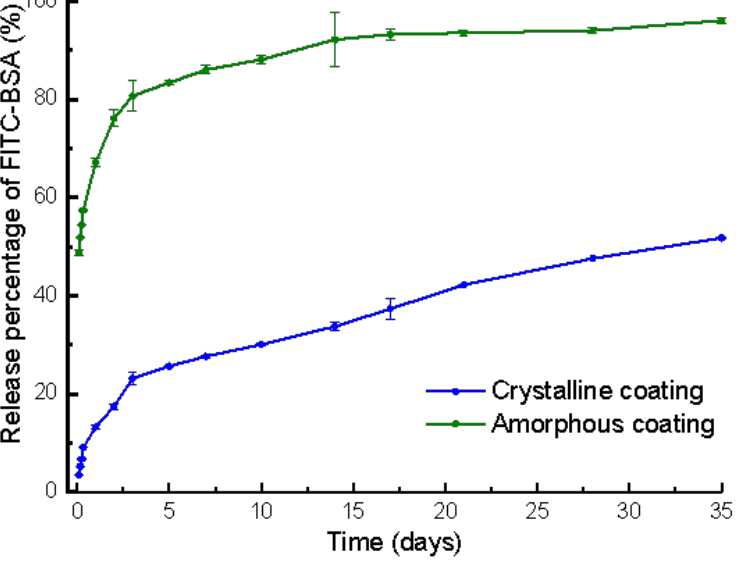
Figure 4. Graph depicting the temporal release profiles of fluorescein isothiocyanate conjugated- bovine serum albumin (FITC-BSA) incorporated in amorphous and crystalline coatings on mini-pin implants. Mean values (n = 3 for each coating) were presented together with the standard deviation.